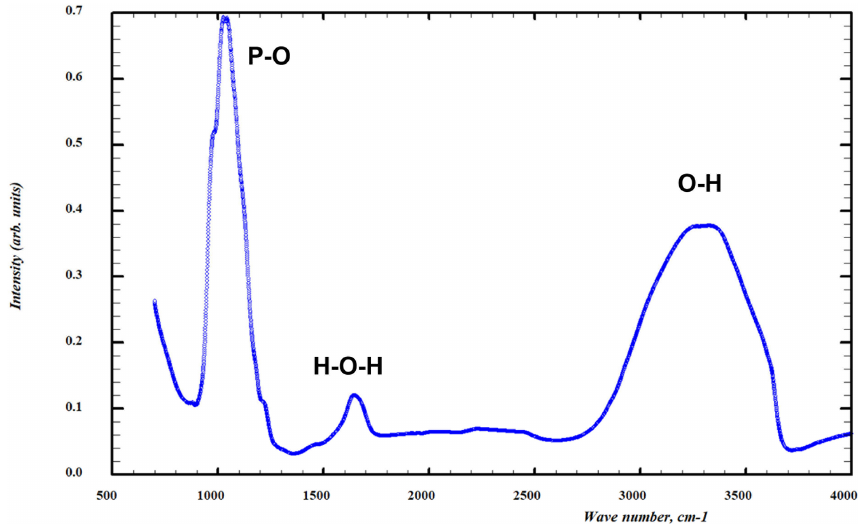
Figure 5. Infrared spectrum for